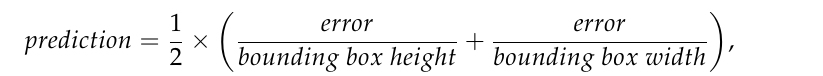
Figure 5. Di ff erence between the center of a bounding box and the center of the bo tt om plate of a rectangular prism. rectangular